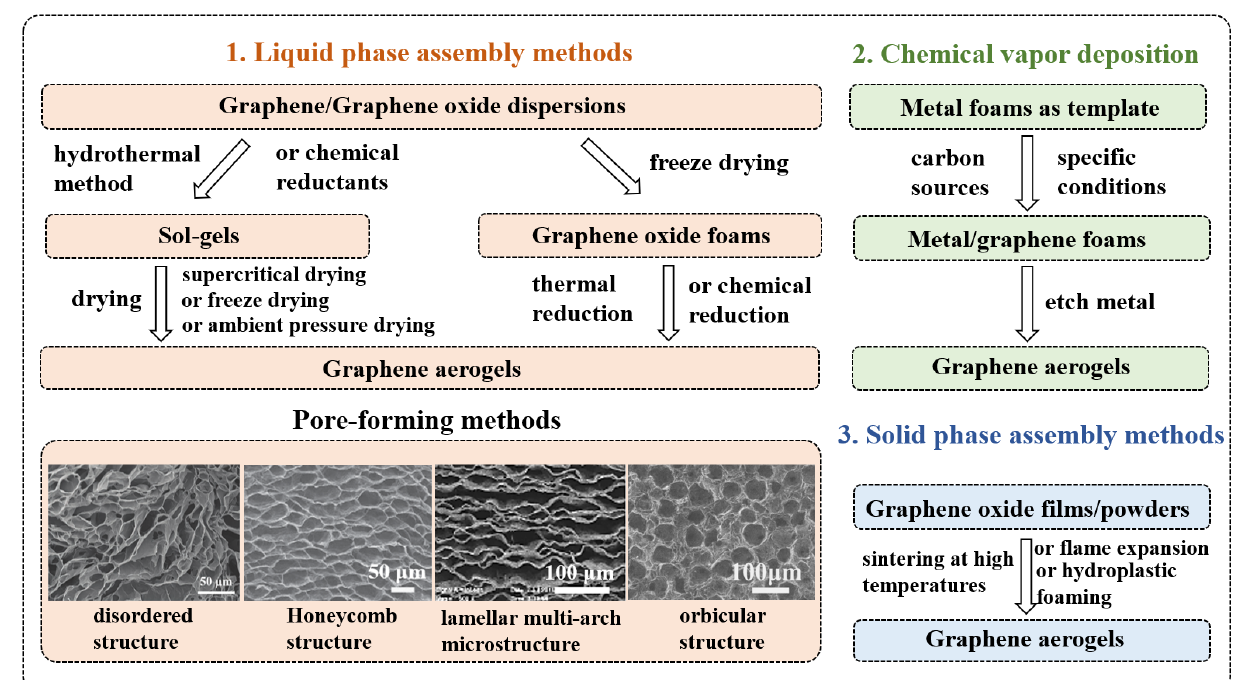
Figure 2. Preparation methods summary of graphene aerogels.